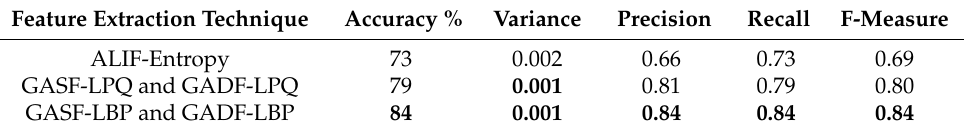
Table 2. Average classification performance results. Best performance is in bold